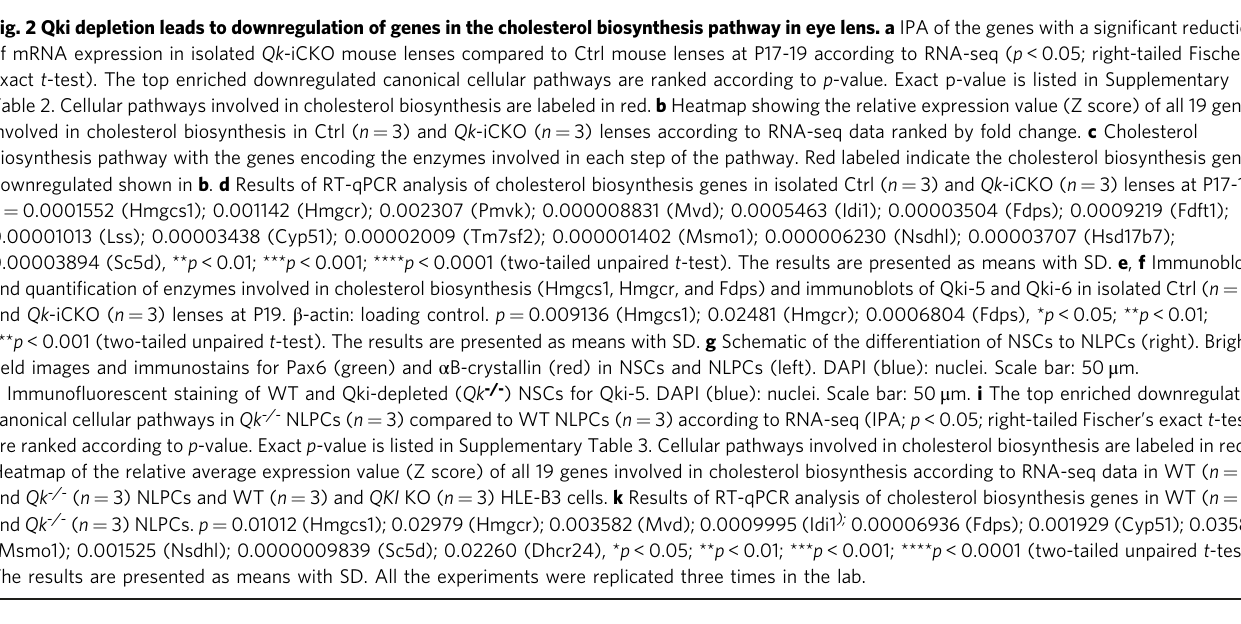
Fig. 2 Qki depletion leads to downregulation of genes in the cholesterol biosynthesis pathway in eye lens. a IPA of the genes with a signi fi cant reduction of mRNA expression in isolated Qk -iCKO mouse lenses compared to Ctrl mouse lenses at P17-19 according to RNA-seq ( p < 0.05; right-tailed Fischer ’ s exact t -test). The top enriched downregulated canonical cellular pathways are ranked according to p -value. Exact p-value is listed in Supplementary Table 2. Cellular pathways involved in cholesterol biosynthesis are labeled in red. b Heatmap showing the relative expression value (Z score) of all 19 genes involved in cholesterol biosynthesis in Ctrl ( n = 3) and Qk -iCKO ( n = 3) lenses according to RNA-seq data ranked by fold change. c Cholesterol biosynthesis pathway with the genes encoding the enzymes involved in each step of the pathway. Red labeled indicate the cholesterol biosynthesis genes downregulated shown in b . d Results of RT-qPCR analysis of cholesterol biosynthesis genes in isolated Ctrl ( n = 3) and Qk -iCKO ( n = 3) lenses at P17-19. p = 0.0001552 (Hmgcs1); 0.001142 (Hmgcr); 0.002307 (Pmvk); 0.000008831 (Mvd); 0.0005463 (Idi1); 0.00003504 (Fdps); 0.0009219 (Fdft1); 0.00001013 (Lss); 0.00003438 (Cyp51); 0.00002009 (Tm7sf2); 0.000001402 (Msmo1); 0.000006230 (Nsdhl); 0.00003707 (Hsd17b7); 0.00003894 (Sc5d), ** p < 0.01; *** p < 0.001; **** p < 0.0001 (two-tailed unpaired t -test). The results are presented as means with SD. e , f